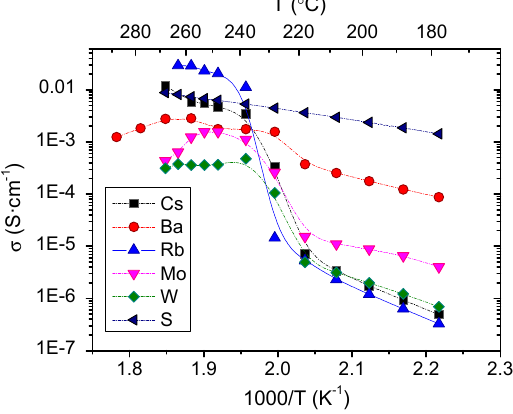
Figure 3. Impedance spectra for CsH 2 PO 4 compound at the studied temperatures: from 180 to 230 °C ( a ) and from 240 to 270 °C ( b ).